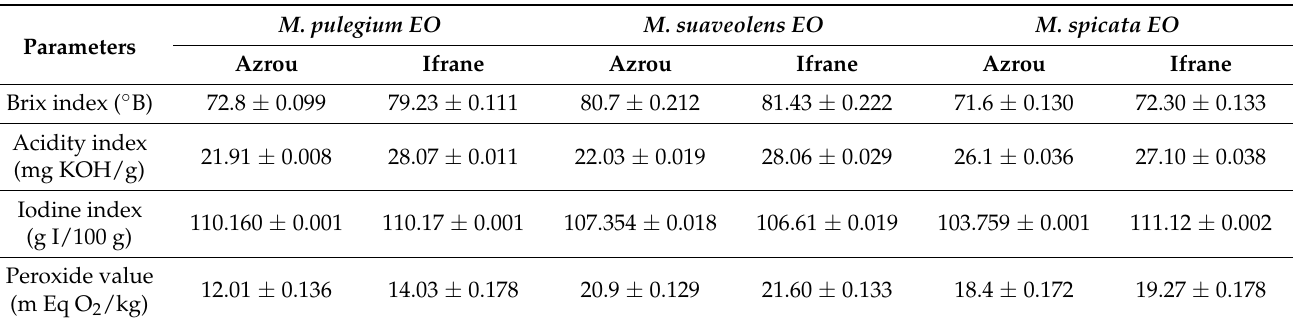
Table 2. Parameters of quality control of mints